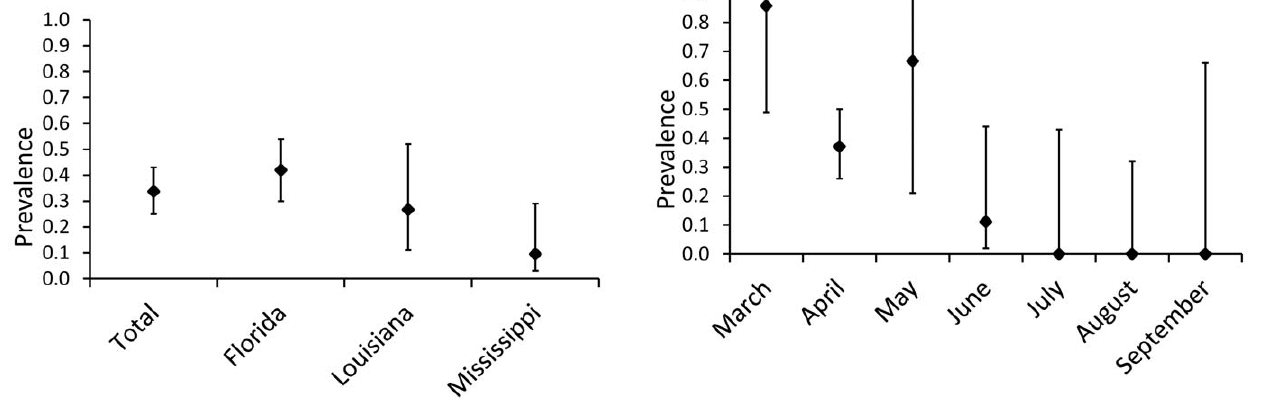
Figure 4. Prevalence of Bd infection for the six months in which sampling was heaviest: March (N=7), April (N=62), May (N=3), June (N=9), July (N=5), and August (N=8). Bars indicate 95% confidence interval.